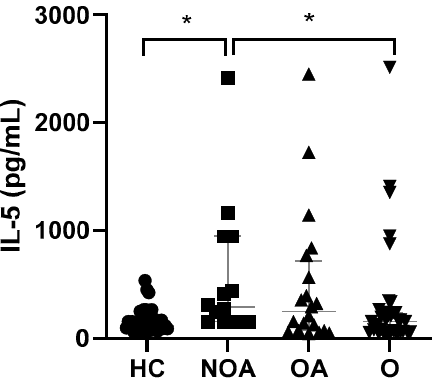
Figure 3. Serum IL-5 level comparisons between groups. Data presented as individual values